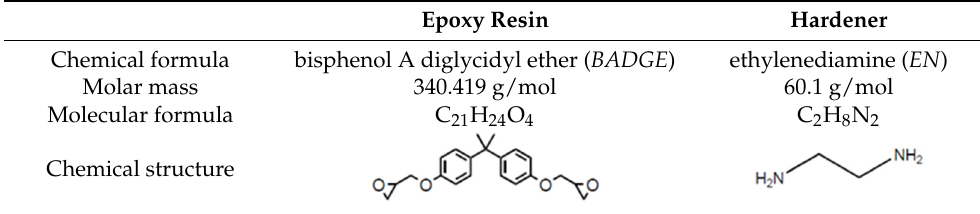
Table 1. Overview of the resin system.